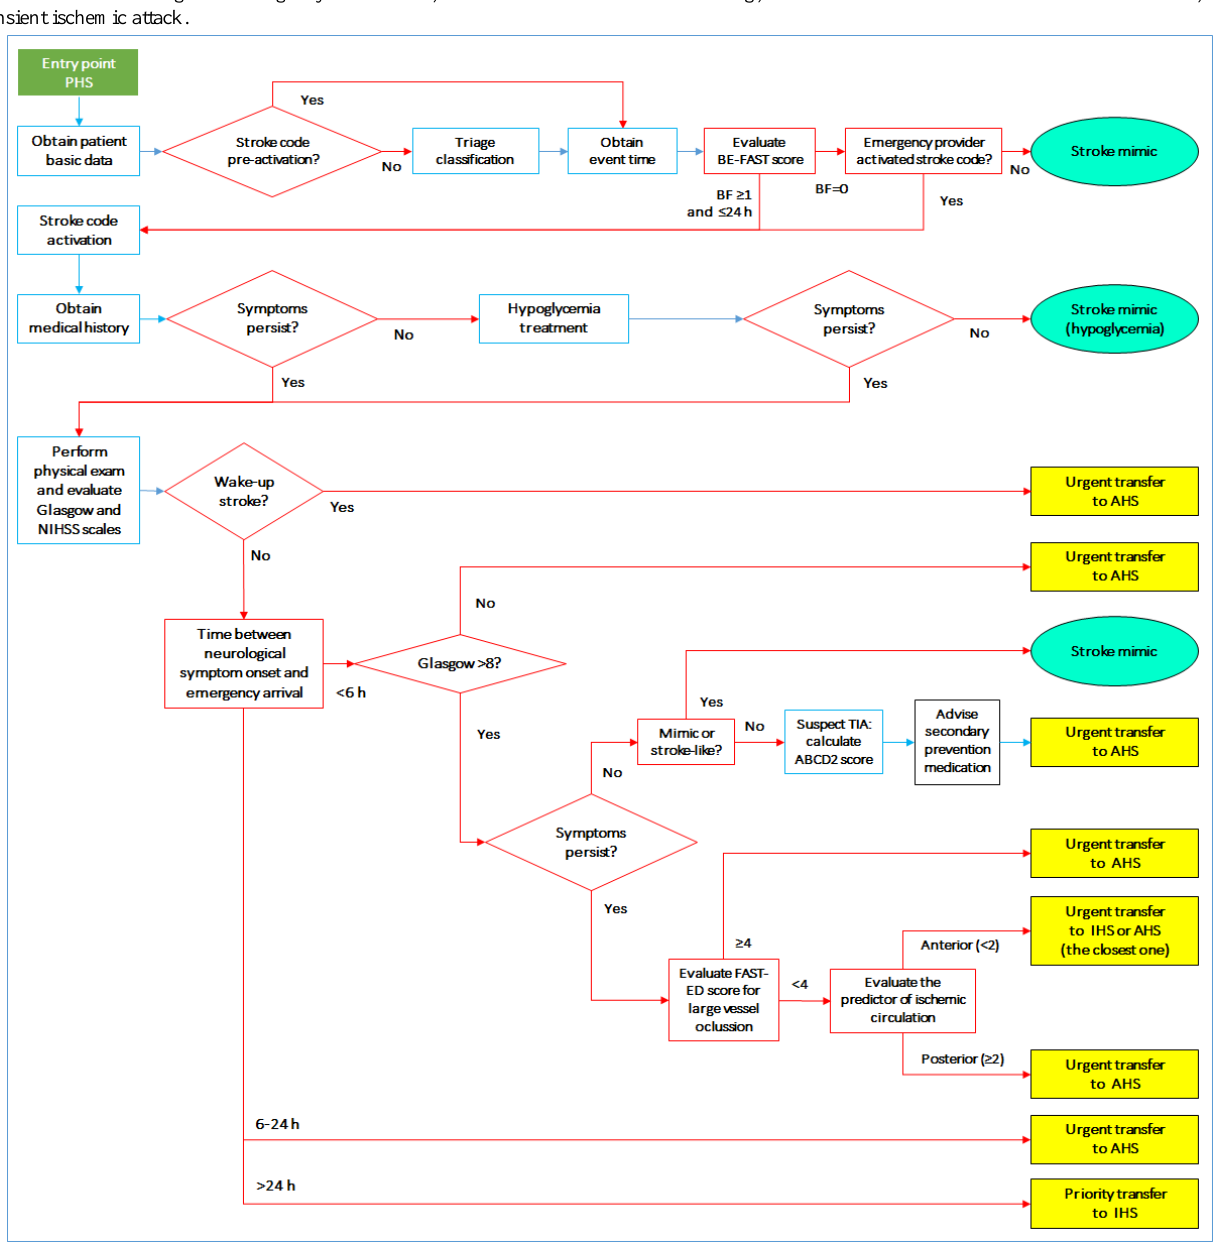
Figure 3. Workflow for the primary health care setting (PHS). AHS: advanced health care setting; Glasgow: Glasgow Coma Scale; FAST-ED: Field Assessment Stroke Triage for Emergency Destination; IHS: intermediate health care setting; NIHSS: National Institutes of Health Stroke Scale; TIA: transient ischemic